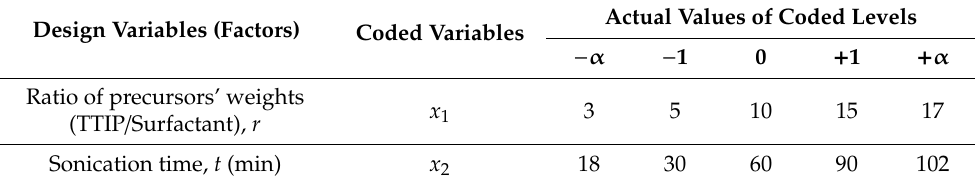
Table 1. Design variables and their coded and actual values used for materials synthesis. Design Variables (Factors)